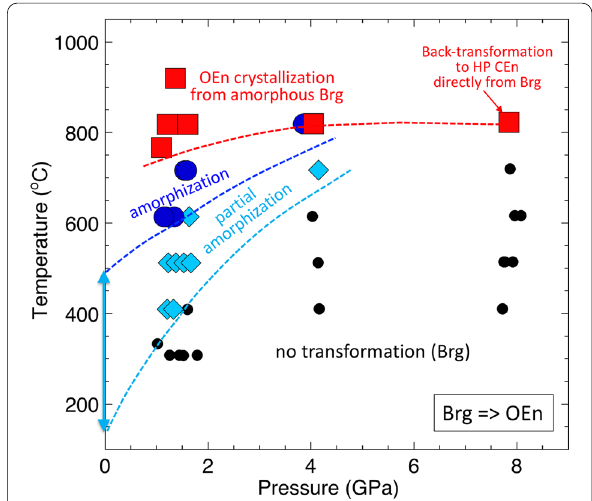
Fig. 5 P–T conditions for the back-transformation in bridgmanite. Bridgmanite (Brg, black circles) becomes amorphous (partially, blue diamonds; completely, blue circles), followed by orthoenstatite crystallization (OEn, red squares) with increasing temperatures at ~ 1–4 GPa, and directly back-transforms to high-P clinoenstatite (HP CEn) at ~ 8 GPa. A double-headed arrow indicates the temperature condition for partially amorphization observed in Durben and Wolf